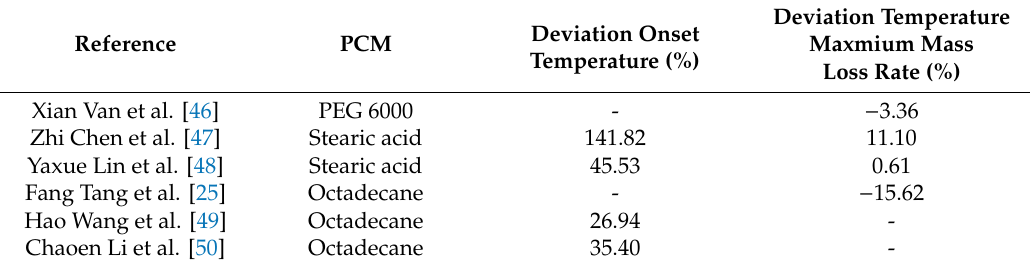
Table 4. Mean values of the deviation of experimental results compared with the corresponding